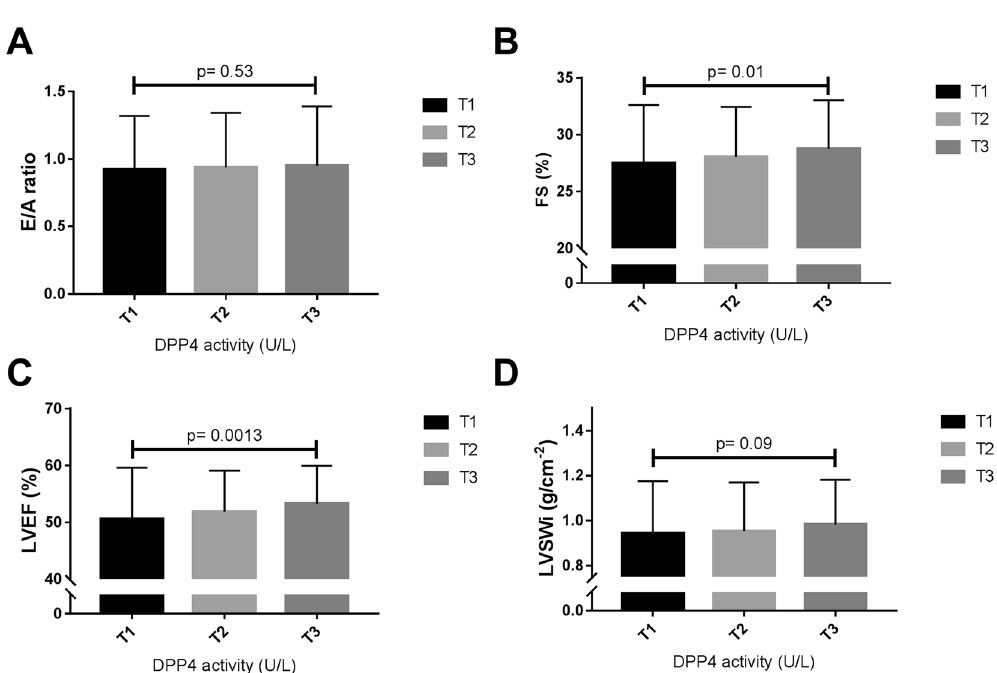
Figure 2. Distribution of echocardiographic parameters assessing left ventricular diastolic and systolic function of STEMI patients according to plasma DPP4 activity tertiles. Bar graphs show the mean ± SD for E/A ratio ( A ), subendocardial fractional shortening (FS) ( B ), left ventricular (LV) ejection fraction (LVEF) ( C ) and LV stroke work corrected by LV end-diastolic volume (LVEDV) (panel D). E, maximum early transmitral velocity in diastole; A, maximum late transmitral velocity in